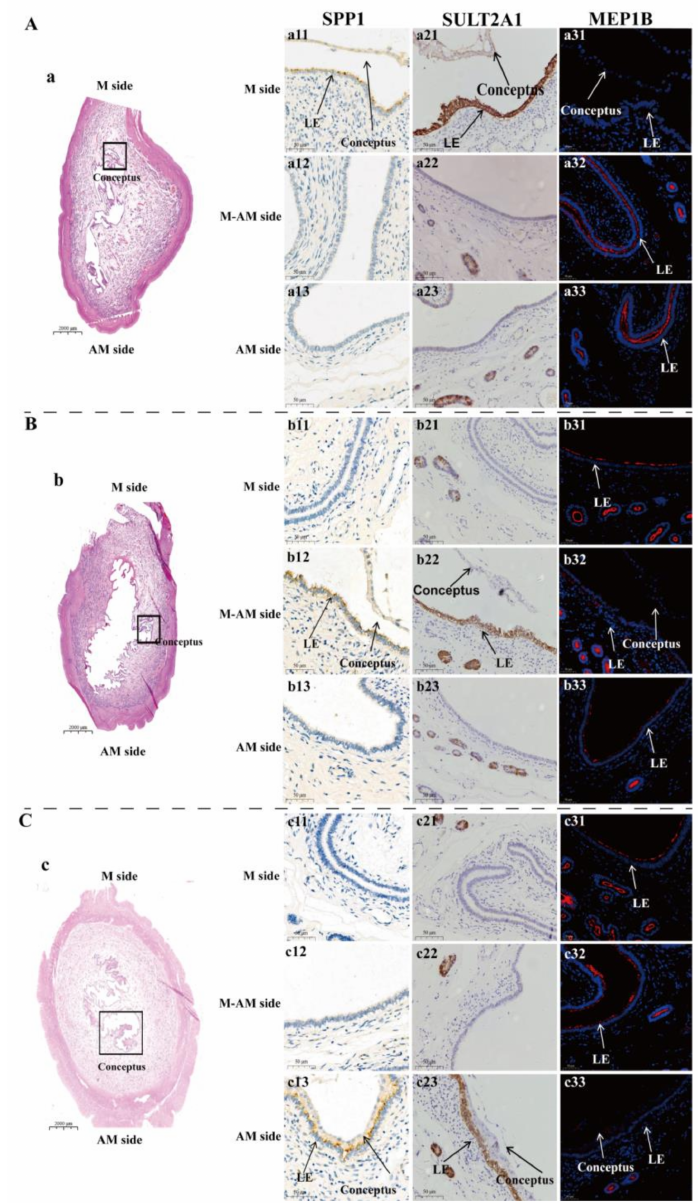
Figure 5. Expression of SPP1, SULT2A1 and MEP1B in the endometrial luminal epithelium in two types of pig uterine samples defined in terms of conceptus localization in the uterus at gestational day 15. ( A ) Representative images taken from uterine cross-section in which conceptus is located in the mesometrial side ( n = 3 gilts). ( B , C ) Representative images taken from uterine cross-section in which conceptus is located away from the mesometrial side ( n = 3 gilts, including uterine cross- sections in which conceptus is located between mesometrial side and anti-mesometrial side and in anti-mesometrial side, respectively.) ( a – c ) Hematoxylin and eosin-stained whole uterine cross- section. Higher magnification images were taken from the same uterine cross-section and show the localization of the 3 proteins in endometrial regions from the M side (( a11 , b11 , c11 ) for SPP1; ( a21 , b21 , c21 ) for SULT2A1; ( a31 , b31 , c31 ) for MEP1B), between M and AM side (( a12 , b12 , c12 ) for SPP1; ( a22 , b22 , c22 ) for SULT2A1; ( a32 , b32 , c32 ) for MEP1B) and AM side (( a13 , b13 , c13 ) for SPP1; ( a23 , b23 , c23 ) for SULT2A1; ( a33 , b33 , c33 ) for MEP1B) of the uterus, respectively. LE: luminal epithe- lium; M side: mesometrial side; AM side: anti-mesometrial side. Scale bars = 50 µ